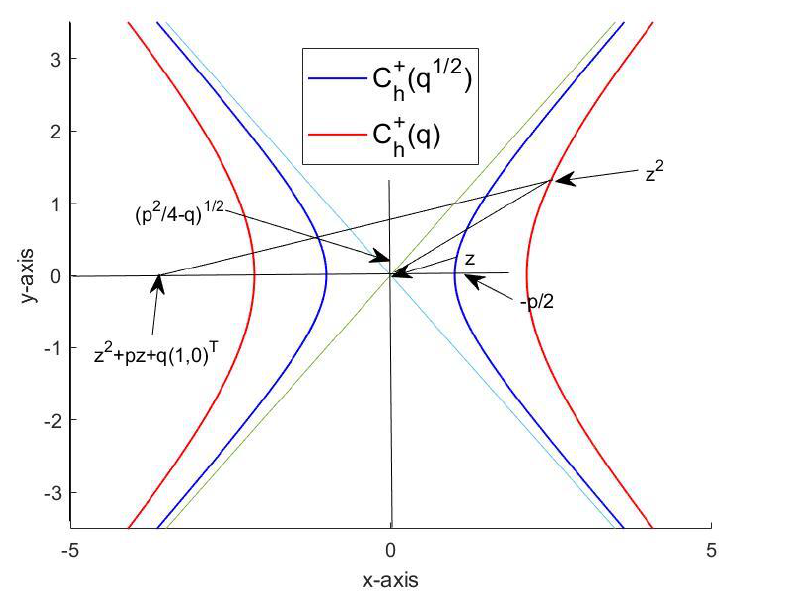
Figure 6. The solutions of the quadratic vector